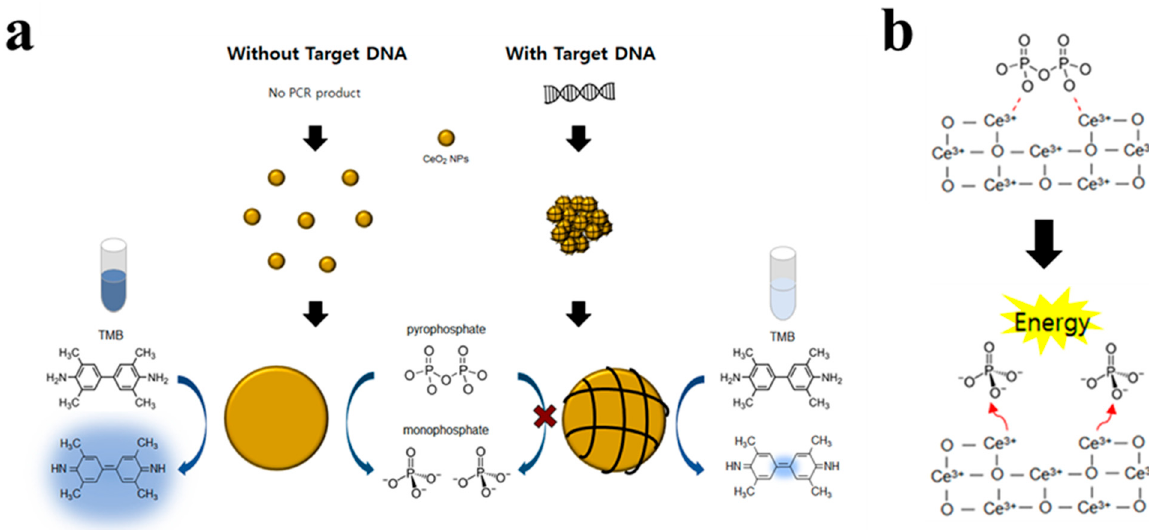
Figure 1. ( a ) Schematic illustration of the proposed CeO 2 NPs-based colorimetric detection of target DNA using pyrophos- phate (PPi) as an enhancer. ( b ) Reaction mechanism for the hydrolysis of phosphate ester bonds in PPi by CeO 2 NPs.